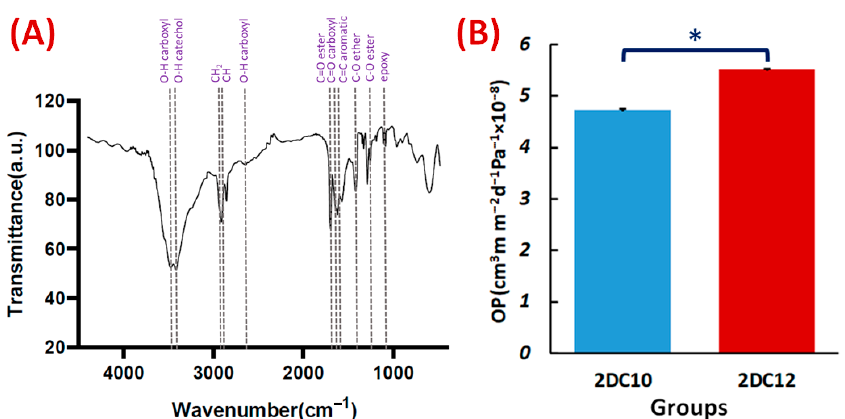
Figure 6. Characterisation of Alg-GO hydrogel: ( A ) FTIR spectrum of Alg-GO (2DC12) hydrogel. ( B ) The OP properties of 2DC10, and 2DC12 hydrogels ( n = 3) (* p < 0.05).